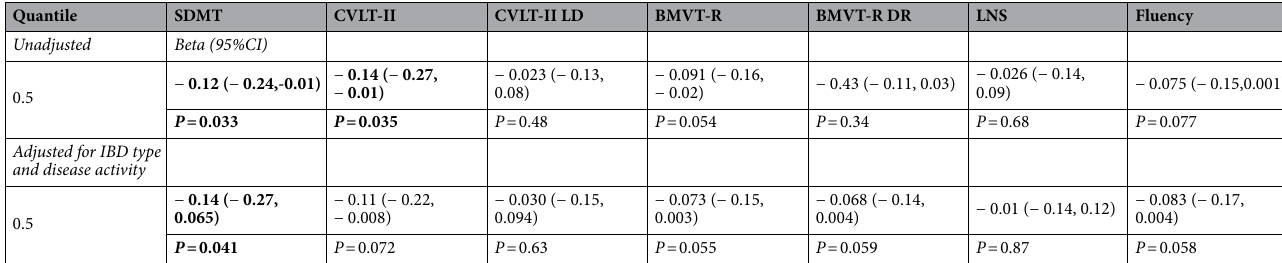
Table 5. Unadjusted and adjusted regression coeffecients (95% confidence intervals) for the association between FRS and cognitive functioning. Significant values are in bold. Sign using wald test as are the other ones sign using LR test. SDMT Symbol Digit Modalities Test, CVLT-II California Verbal Learning Test-II, LD Long Delay, BVMT-R Brief Visuospatial Memory Test-Revised, DR Delayed Recall, LNS Letter-Number Sequencing